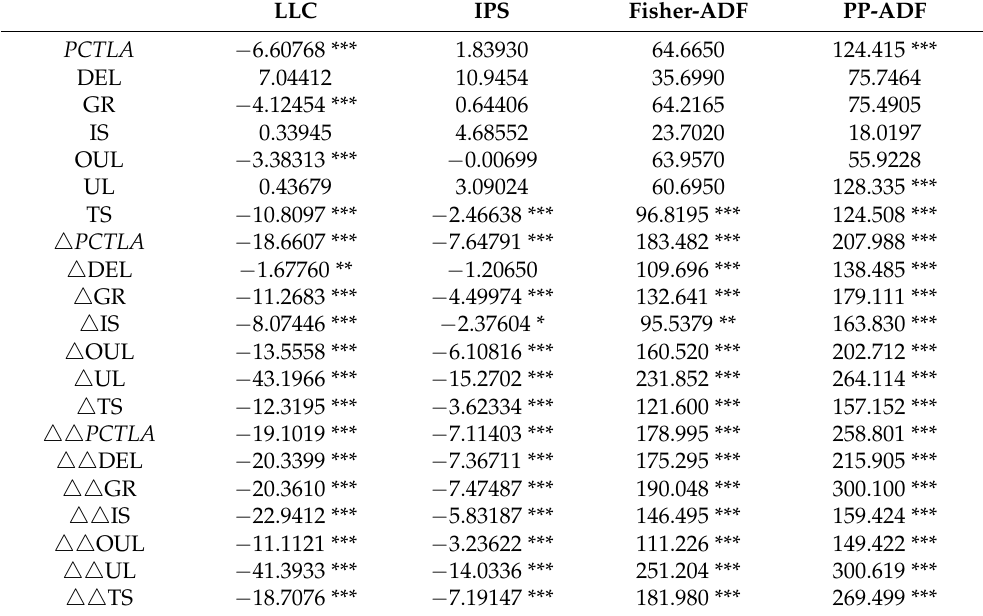
Table 5. The results of the unit root